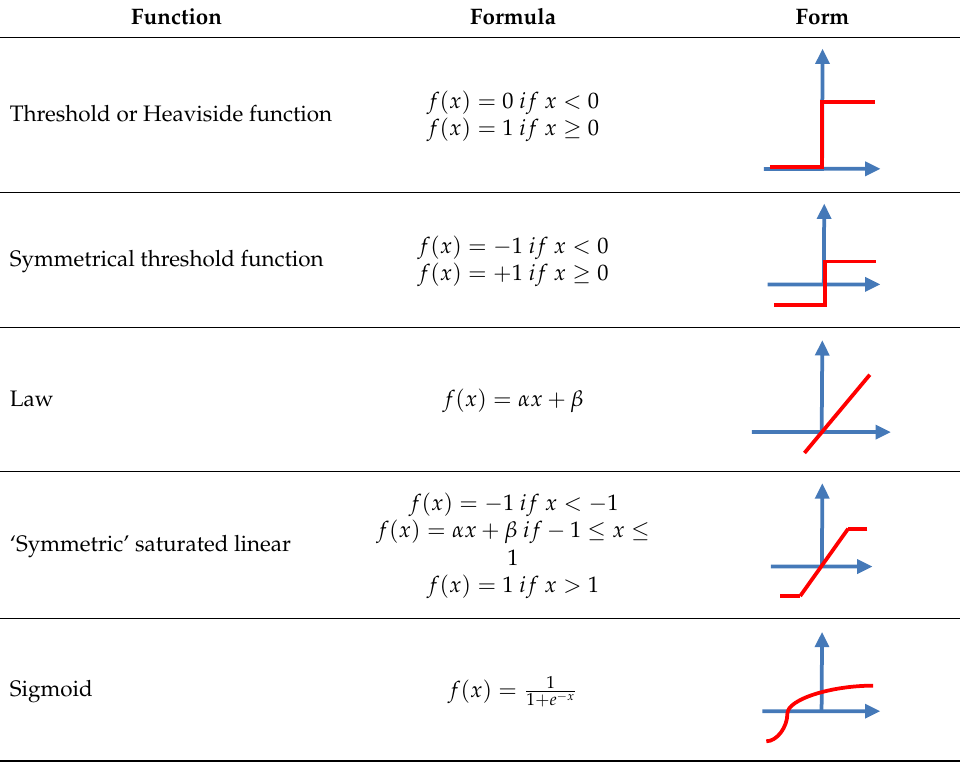
Table 3. Some activation